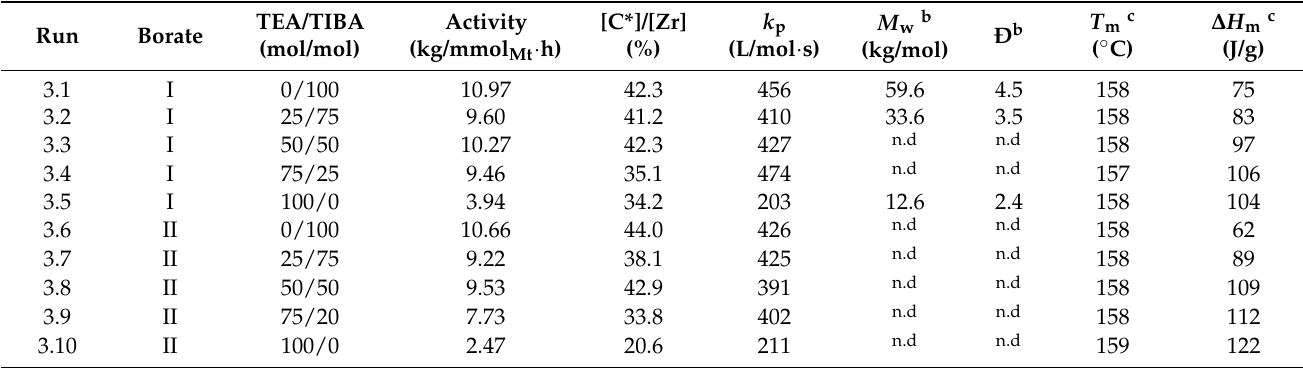
Table 3. Results of propylene polymerization Mt-I/borate/alkylaluminum a .